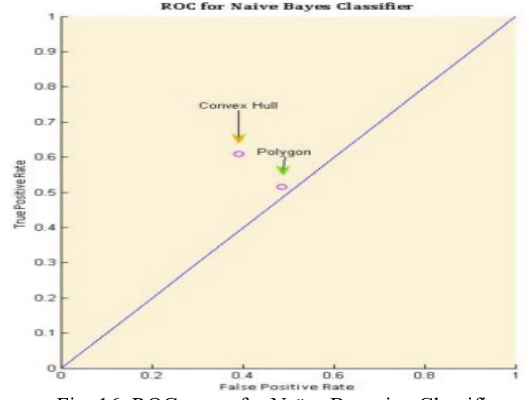
Fig. 16. ROC space for Naïve Bayesian Classifier